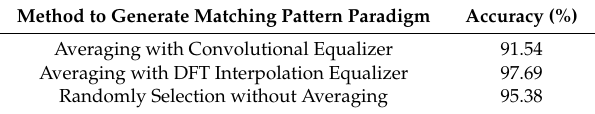
Table 6. Comparison of matching pattern paradigm selection methods.